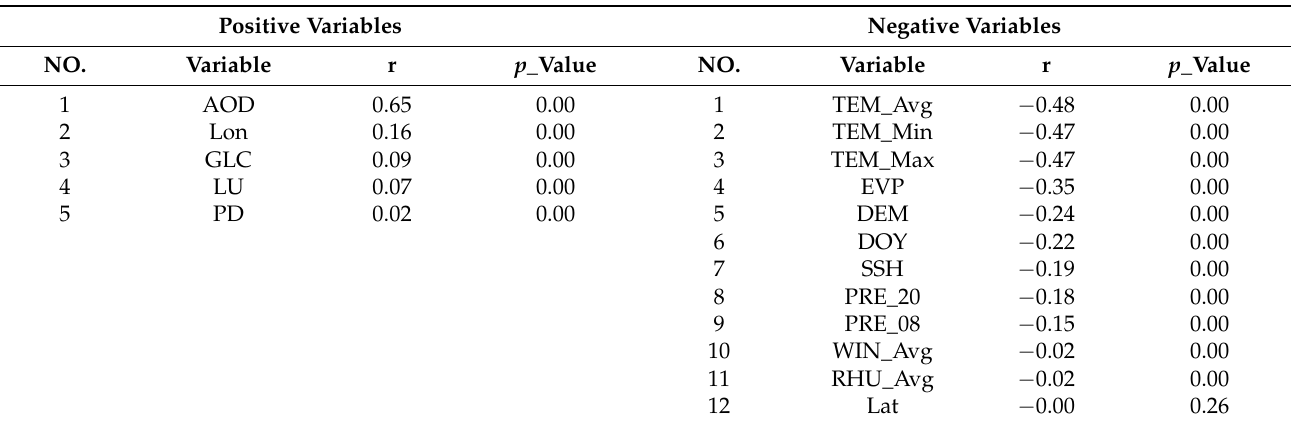
Table 2. Pearson correlation coefficients and p _values of each variable on PM 2.5 concentrations from the monitoring stations in GUA from